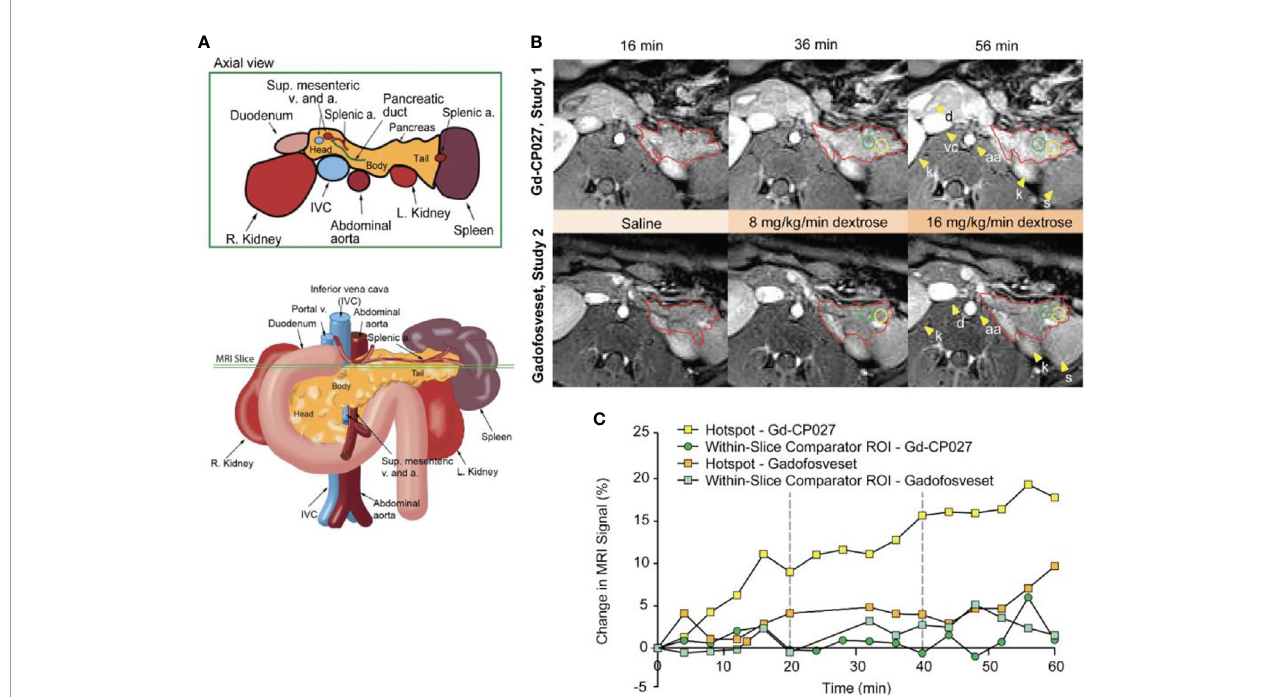
FIGURE 2 | (A) Schematic illustrating non-human primate abdominal anatomy, including organs surrounding the pancreas, and an axial cross-section indicating imaging slice used for MRI pancreas localization and quanti fi cation. (B) In vivo MR imaging of non-human primate after infusion of Gd-CP027 (Study 1), and gadofosveset (Study 2). Both studies received the altered GGI, and 3D T 1 -weighted images were collected every four minutes. Axial images show the T 1 -weighted scans at 16, 36, and 56 min time points, where each represent the scan after complete saline infusion, 8 mg/kg/min dextrose, and 16 mg/kg/min dextrose infusion, respectively. The tail of the pancreas is highlighted in both panels (red) and Gd-CP027 shows a more prominent enhancement in the pancreas, with focal signal enhancements intensifying over time. Hotsposts (yellow) and adjacent comparator ROIs (green) were identi fi ed and measured, and are plotted in (C) for the animal displayed in (B)